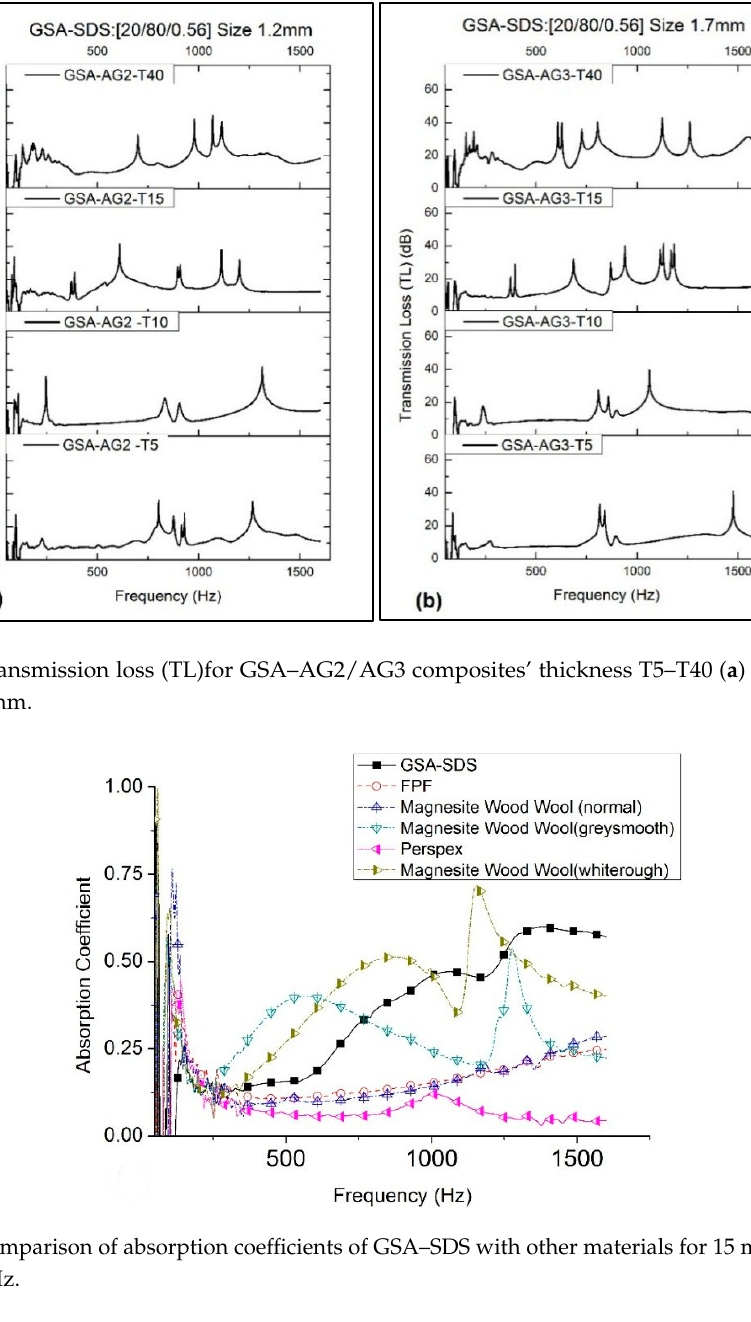
Figure 6. Comparison of absorption coefficients of GSA–SDS with other materials for 15 mm thickness at 50–1600Hz.